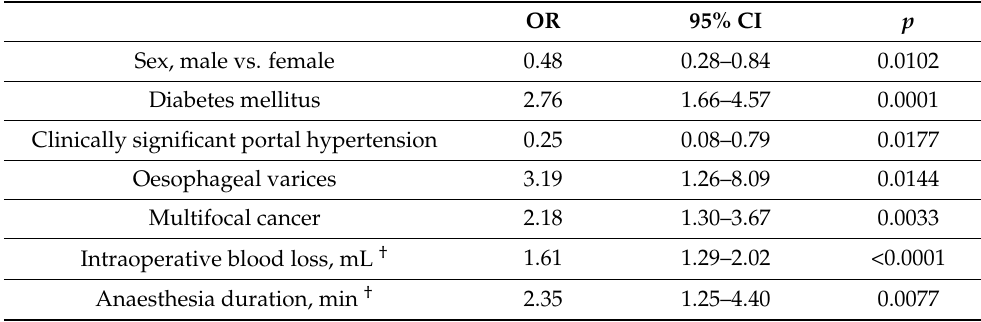
Table 4. Independent factors for Clavien–Dindo grade III or IV complications. OR 95% CI Sex, male vs.